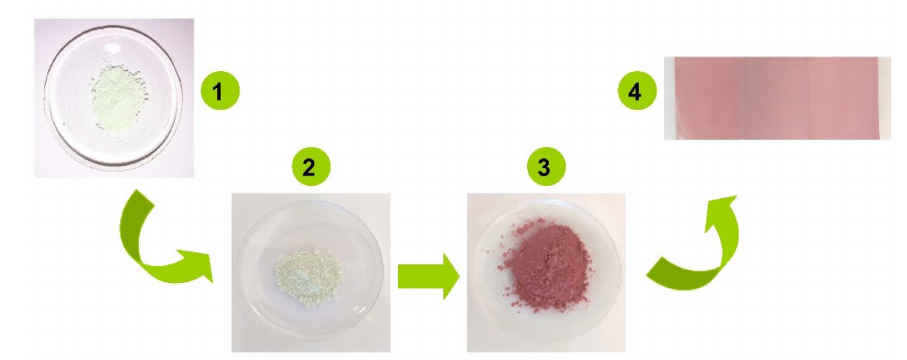
Figure 1. Steps for heterostructure